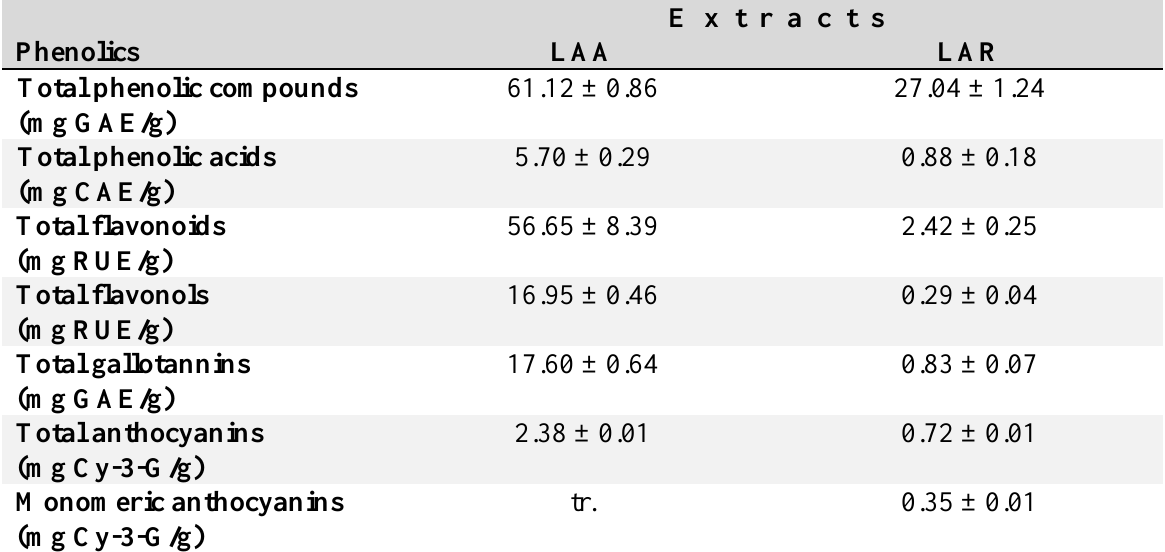
Table 1. The total contents of various classes of phenolic compounds in Lunaria annua aboveground part and root extracts (LAA and